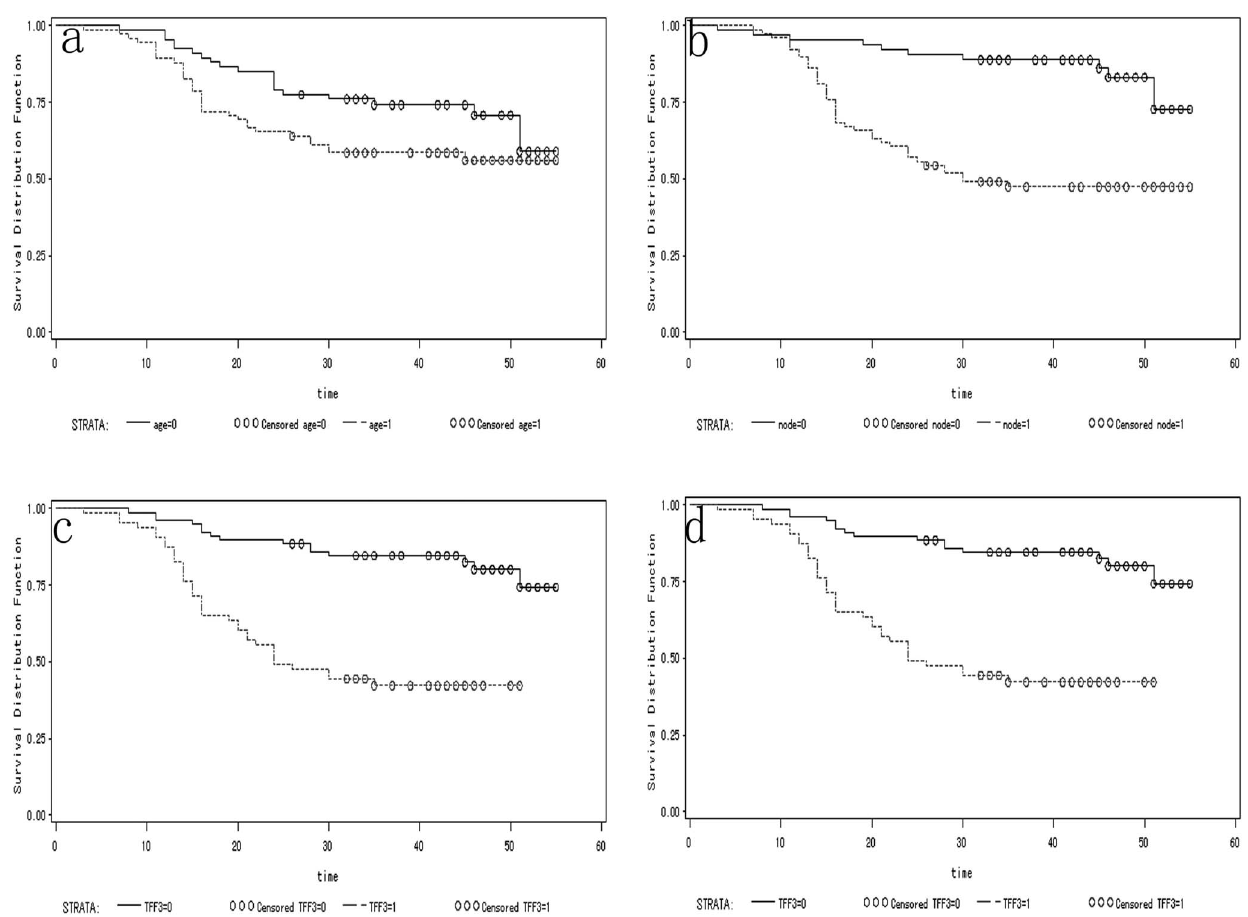
Figure 2. Kaplan-Meier overall survival curves of 142 GC patients according to age (a), lymph node metastasis (b), TFF3 expression (c), and TACC1 expression (d) (P , 0.05). Abbreviations: age=0 means age # 60 years; age=1 means age . 60 years. node=0 means no lymph node metastasis; node=1 means lymph node metastasis.